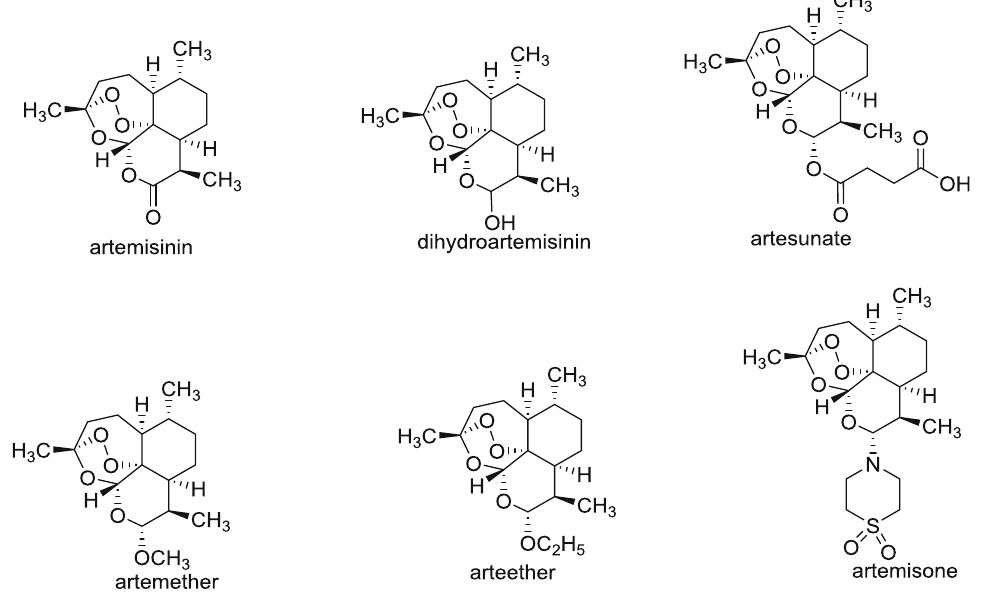
Fig. 1 Chemical structures of artemisinin and its common bioactive